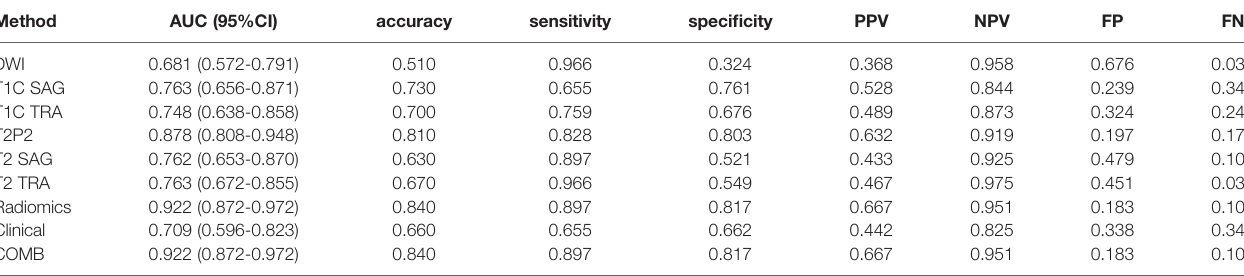
TABLE 2 | Discriminative value of each parameter in differentiating LVSI.